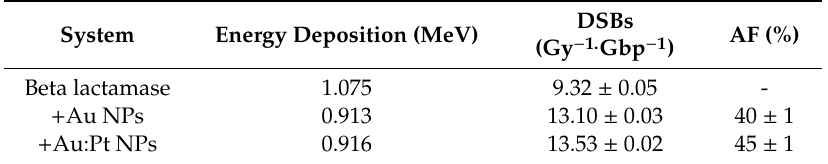
Table 5. Nanosize damage (DSBs) from Geant4-DNA simulation based on the energy deposited (MeV) in the beta-lactamase section of the pBR322